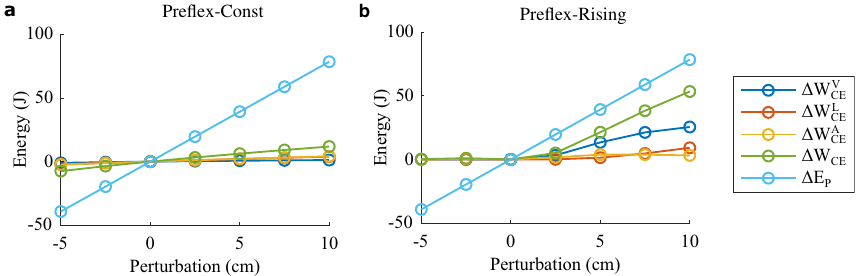
Figure 5. Change in muscle fibre work caused by each step perturbation (circles) with respect to the reference hopping condition. ∆ E P (light blue) is the amount of work adjustment required to reject, within the preflex duration, the potential energy change caused by each step perturbation. ∆ W CE (green) is the net change in V muscle fibre work. ∆ W CE (dark blue) is the change in muscle fibre work induced by the force–velocity relation; L W A ∆ W CE (red) by the force–length relation; ∆ CE (yellow) by the muscle excitation. ( a ) Preflex-Const and ( b )